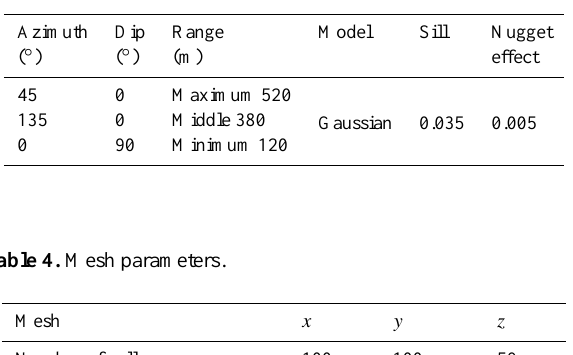
Table 3. Variogram model.